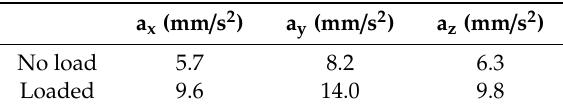
Figure 7. Comparison of the imposed acceleration signal and the acceleration of the moving platform, free and loaded with a person standing on it, along the three directions. Table 4. Mean quadratic errors of the moduli of the acceleration signals measured on the moving platform at frequencies between 1 and 50 Hz.